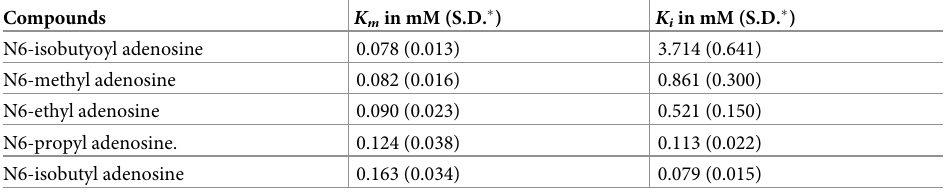
Table 2. K m of NAD and inhibition constants ( K i ) of adenosine analogue compounds for Mycobacterium tubercu- losis L-alanine dehydrogenase.